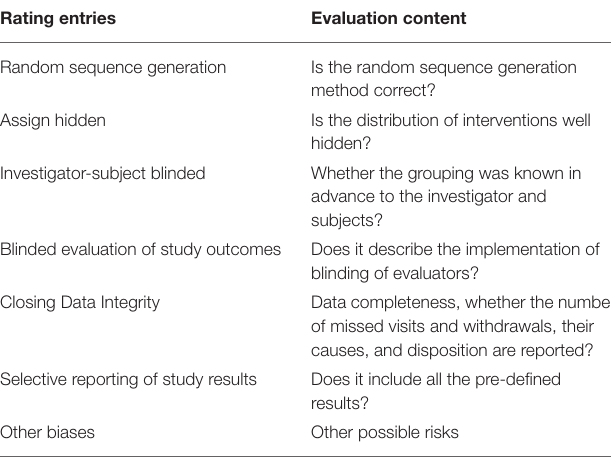
TABLE 1 | The main content of quality